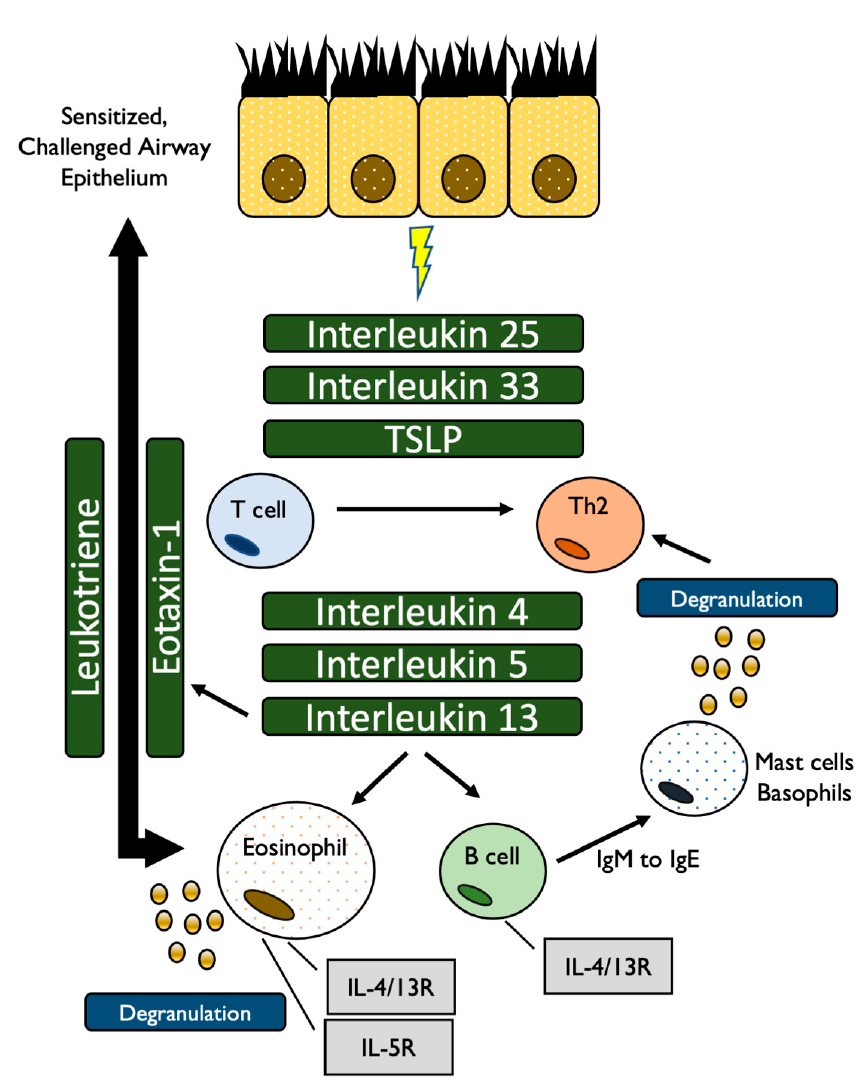
Figure 1. The eosinophil-mediated pathway of asthmatic inflammation [11,12]. Biochemically, allergic asthma is primarily mediated by mast cells, CD4 + T helper-2 (Th2) cells, and the secretion of interleukin 4 (IL-4), IL-5, and IL-13 [13]. First, T-lymphocytes that are recruited by IL-25, IL-33, and thymic stromal lymphopoietin (TSLP) secreted from challenged epithelium cause the release of Type 2 (T2) cytokines, attracting eosinophils and mast cells within the airway tract [13]. Moreover, these T2-cytokines mediate IL-5 release, which stimulates release of IL-4 and IL-13 by innate lymphoid, CD4+ T, and mast cells (among diverse other types such as basophils and NK T cells), as well as eosinophilic inflammation [11,13,14]. IL-4 and IL-13 then cause B-lymphocytes to produce IgE when allergens are detected in the body and, after binding to the IgE receptor (Fc ε